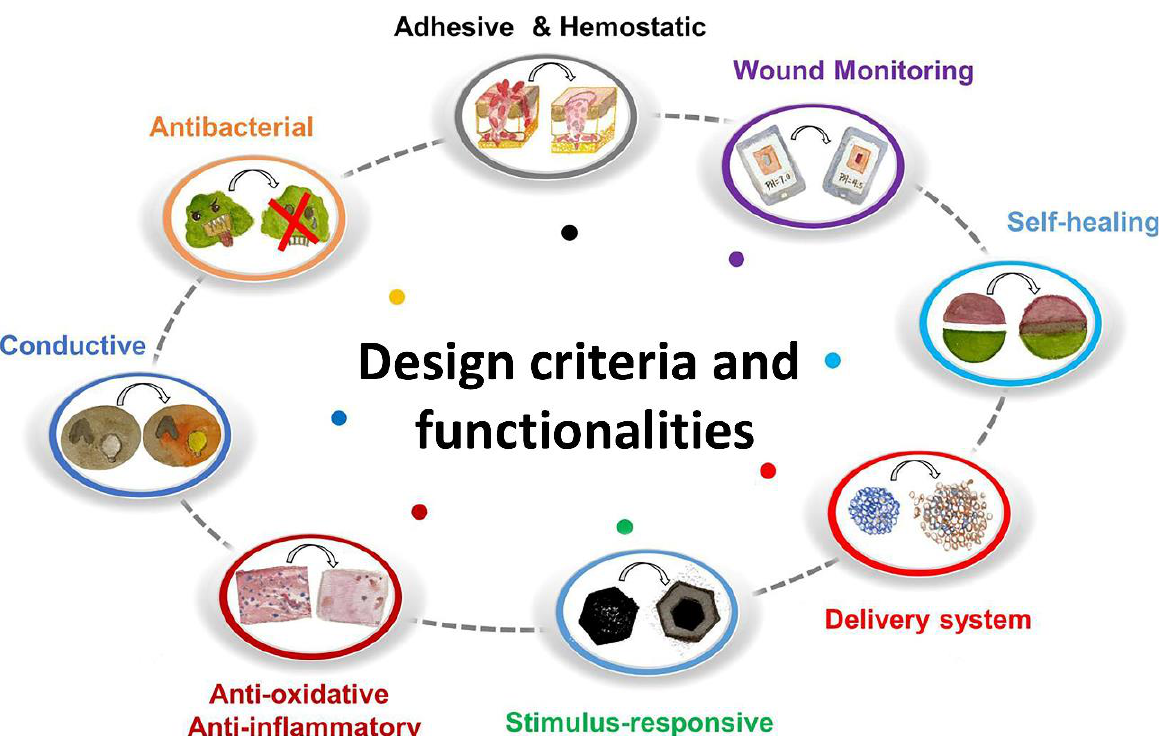
Figure 1. Design criteria and functionalities of hydrogel bio-adhesives for wound healing. Reprinted with permission from ref [33]. Copyright 2021 American Chemical Society.